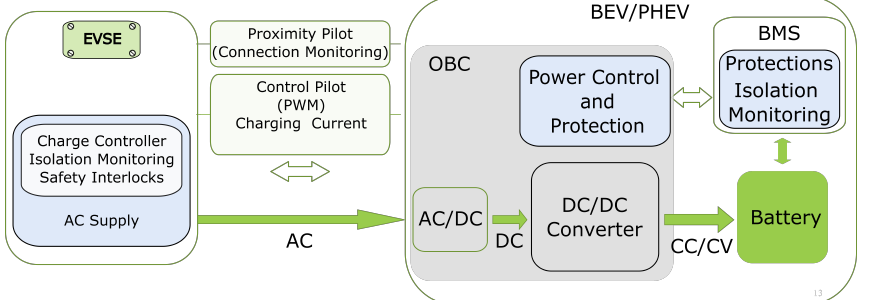
Figure 8. Typical on-board-charger architecture in Mode-3 AC charging configuration (derived from [31,32,89]).